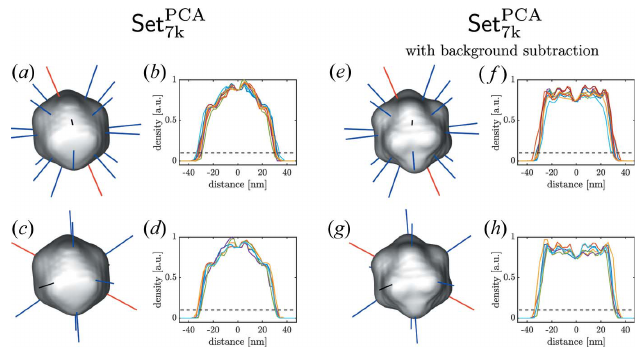
Figure 11 Line scans from facet to facet (top row) and from vertex to vertex (bottom row) in different directions for the selected data set (Set 7kPCA ) without ( a )–( d ) and with ( e )–( h ) background subtraction. The horizontal dotted lines in ( b ), ( d ), ( f ) and ( h ) indicate 10% of the maximum density used for size analysis.